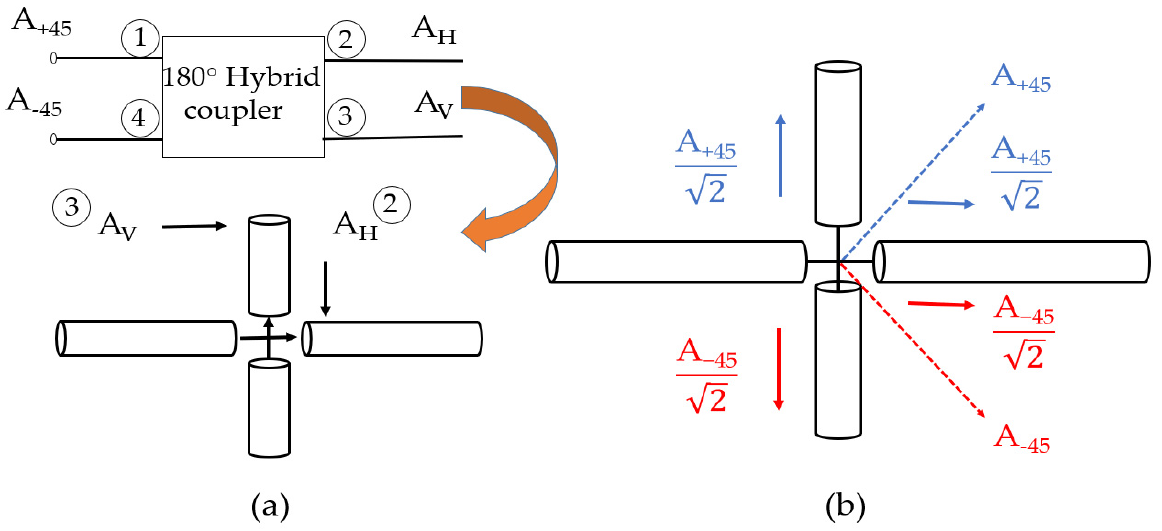
Figure 5. ( a ) Conversion of slant-polarized inputs to H and V polarized inputs, ( b ) creation of virtual slant polarizations from H and V feed signals. slant polarizations from H and V feed